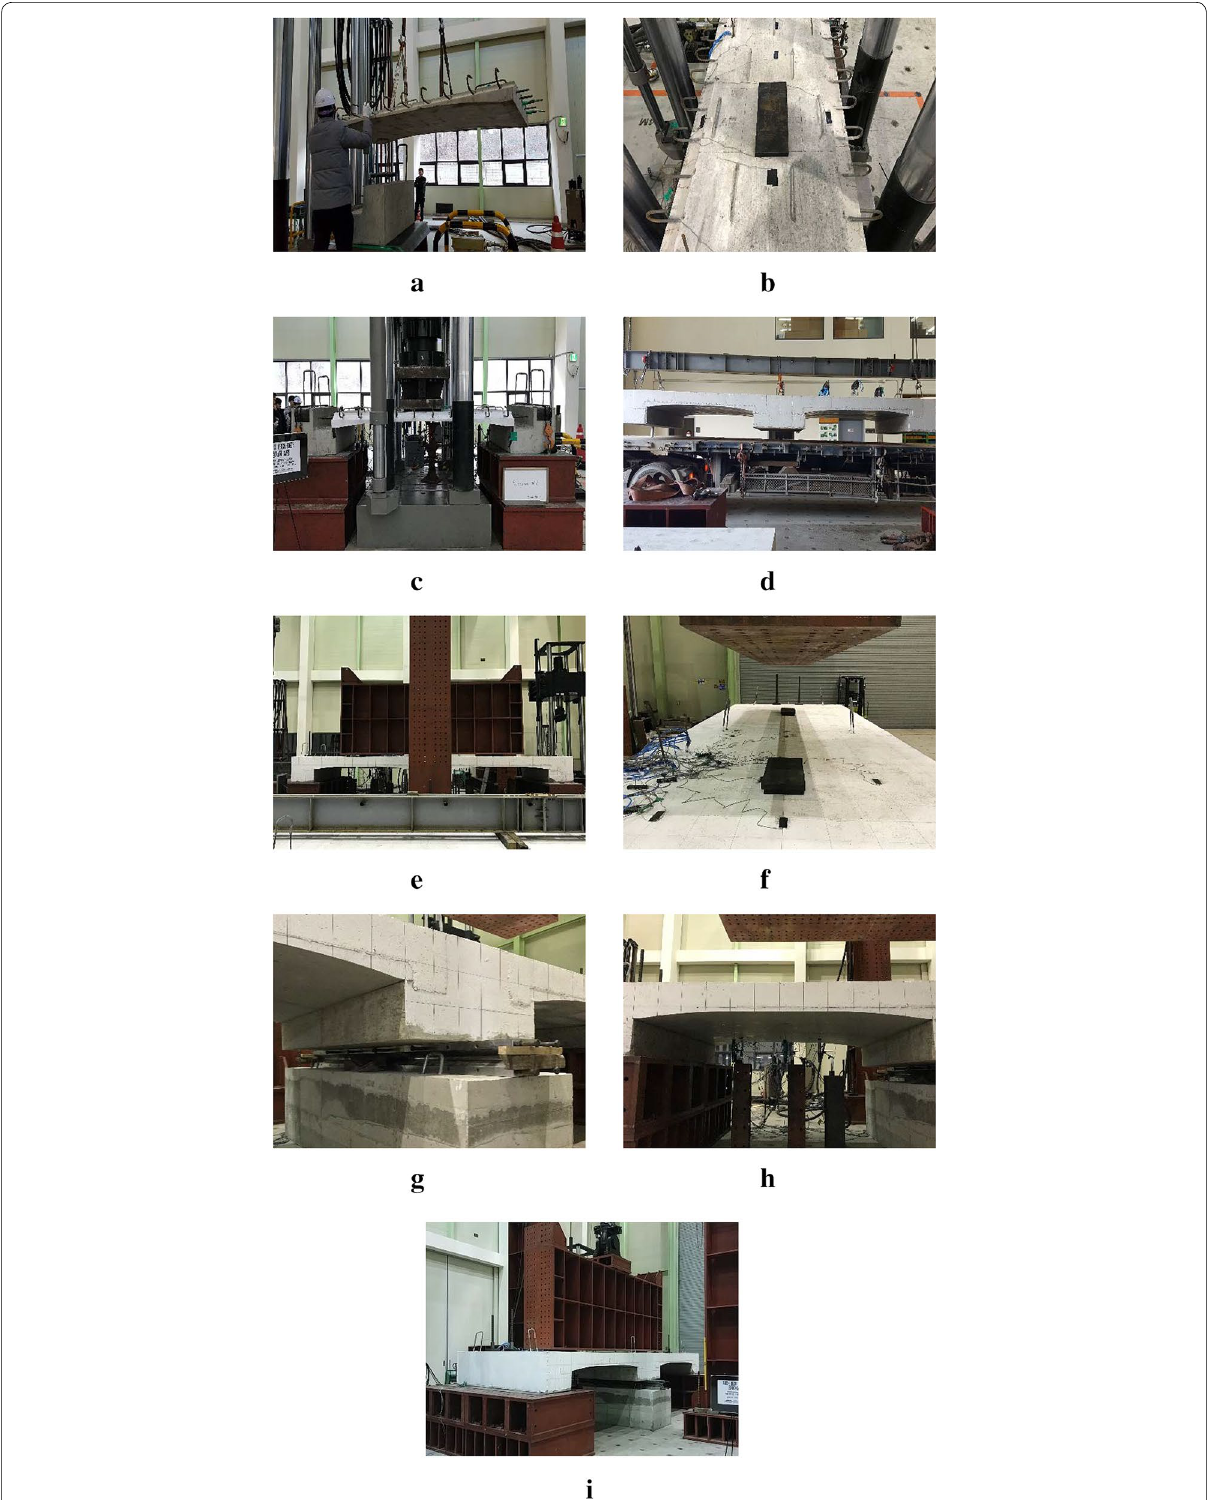
Fig. 3 RC arch deck specimen (BD) static loading test. a AD specimen set‑up. b AD loading area. c AD Static loading test. d Transporting of specimen (BD). e Specimen set up. f Static loading area. g Hinge detail. h LVDT set up. i BD Static loading